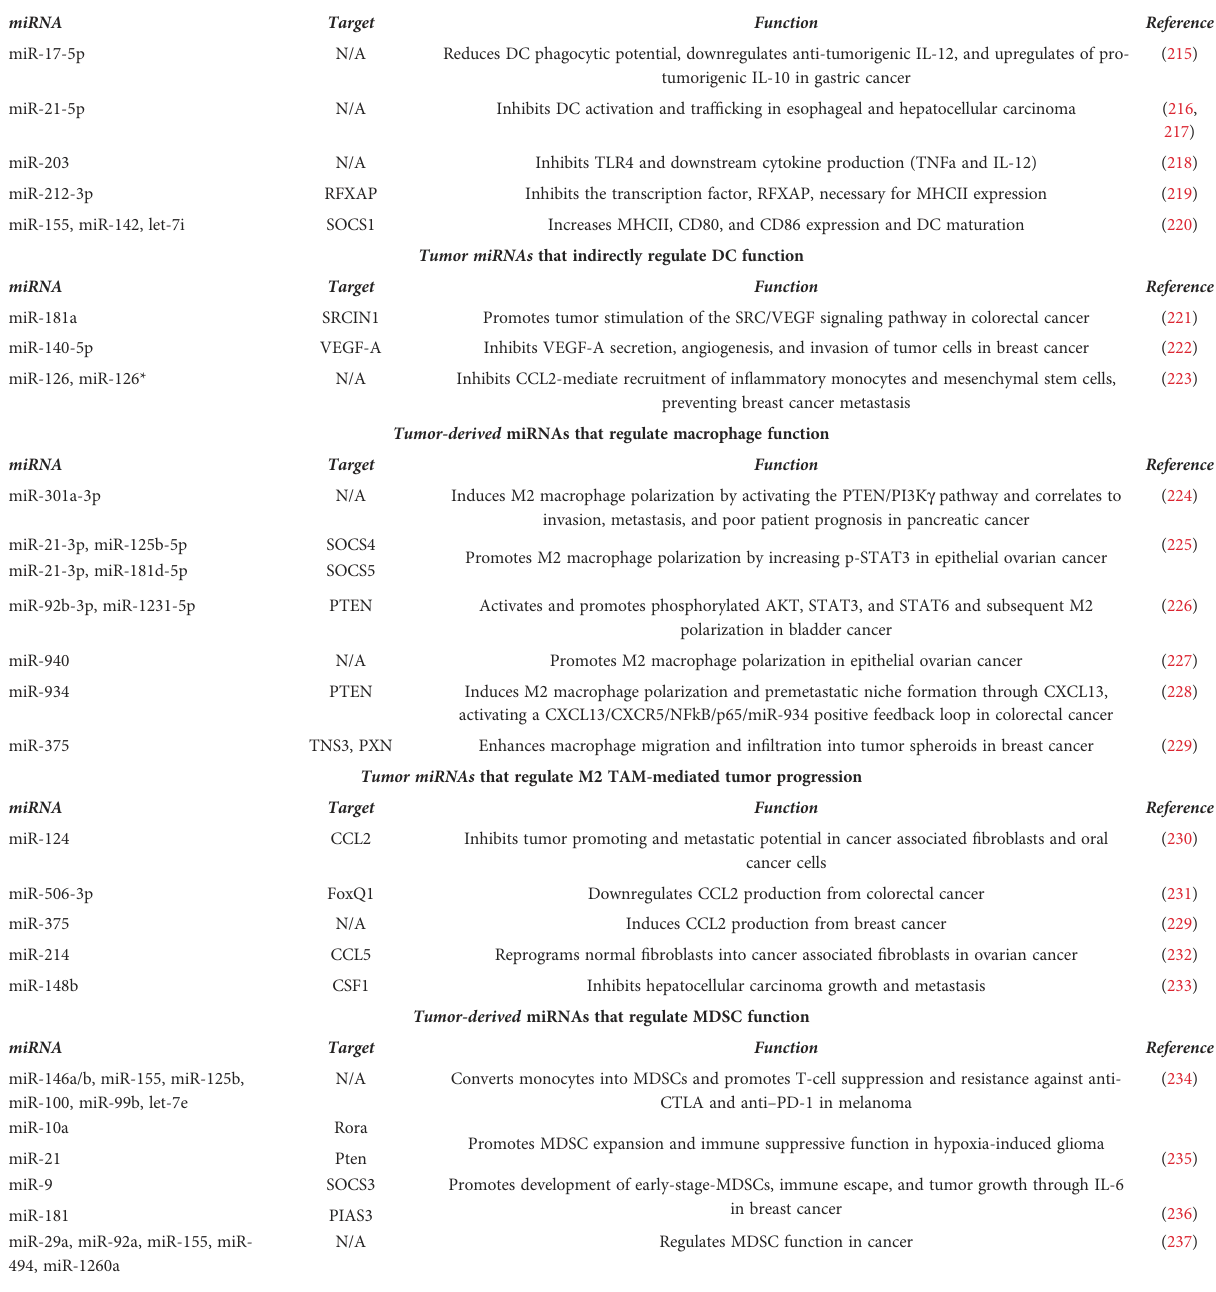
TABLE 3 Tumor-derived and tumor miRNAs, targets, and